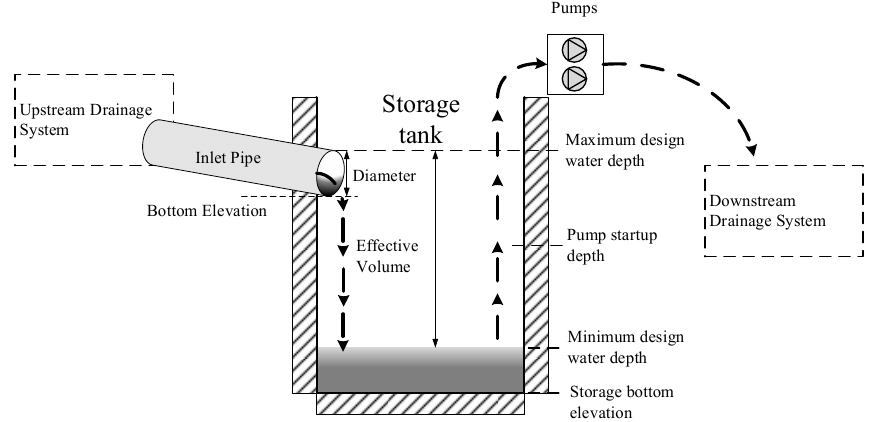
Figure 1. Design parameters of a drainage pumping station.